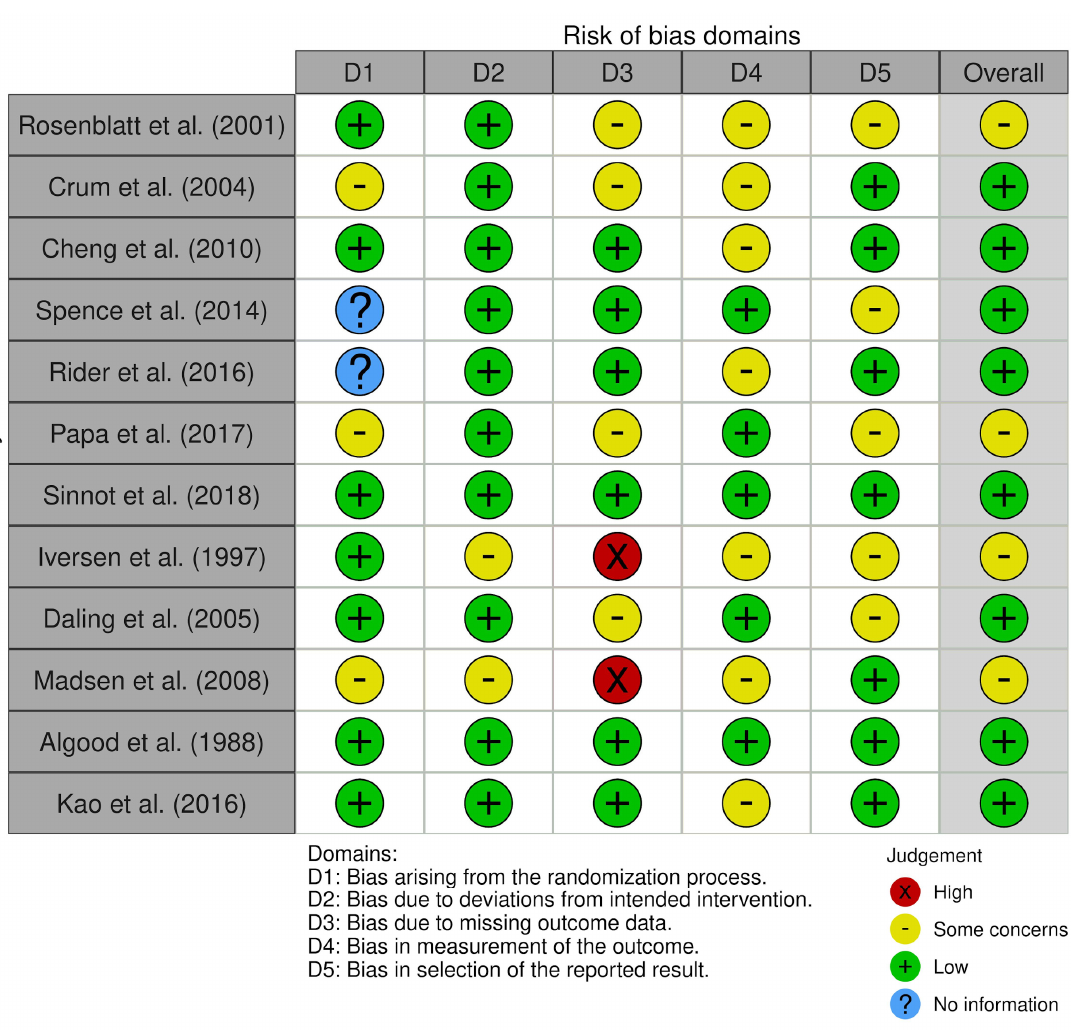
Figure 2. Risk of bias.